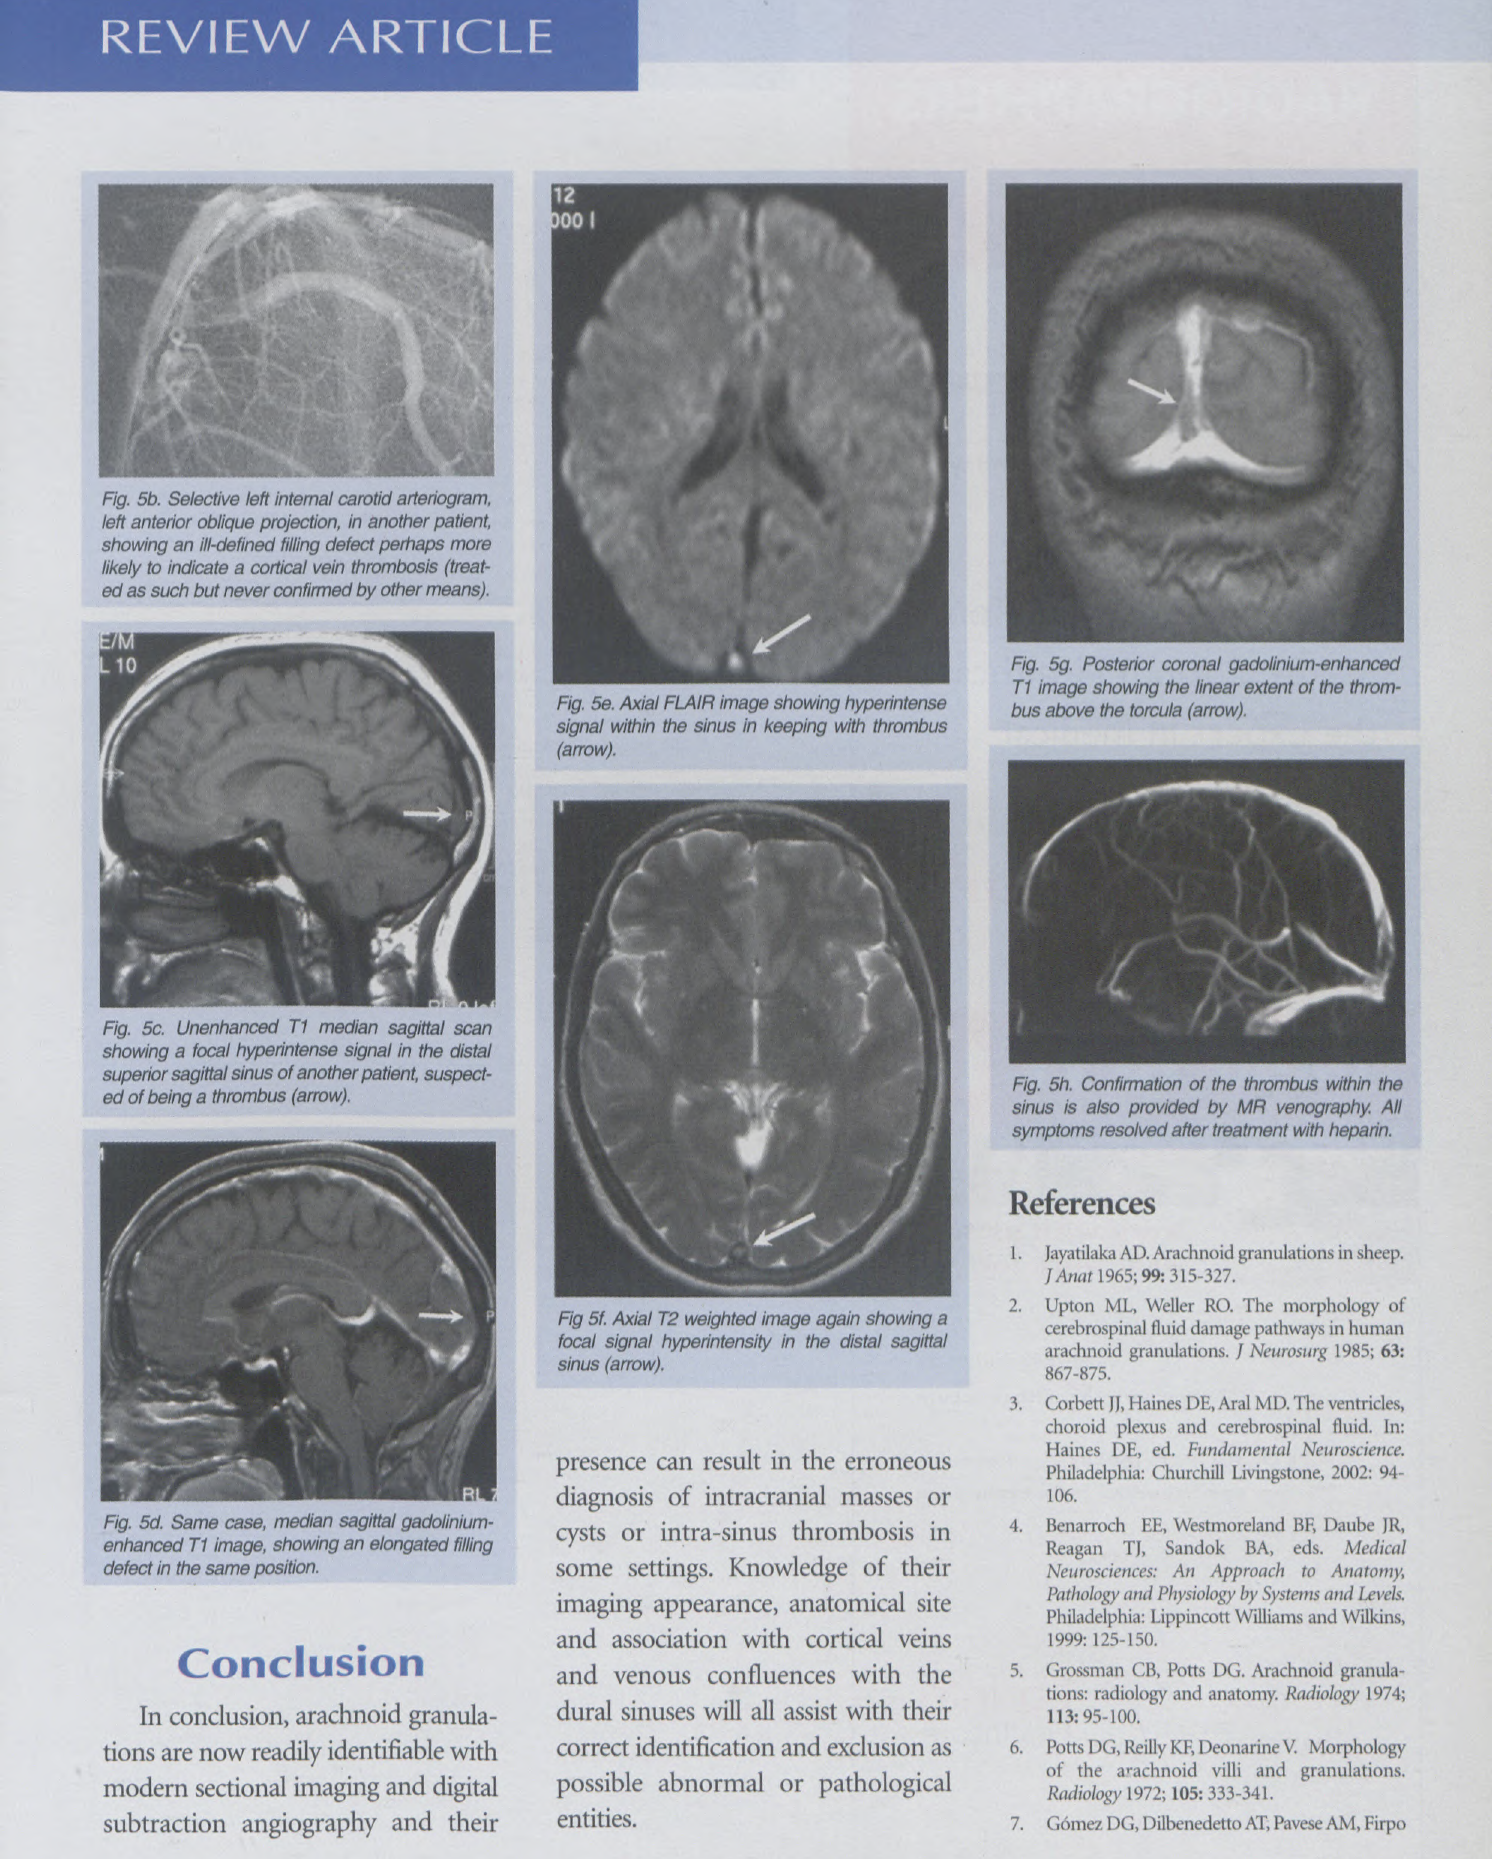
F/g. 5d. Same case, median sagittal gadolinium- enhanced Tt image, showing an elongated filling defect in the same position.